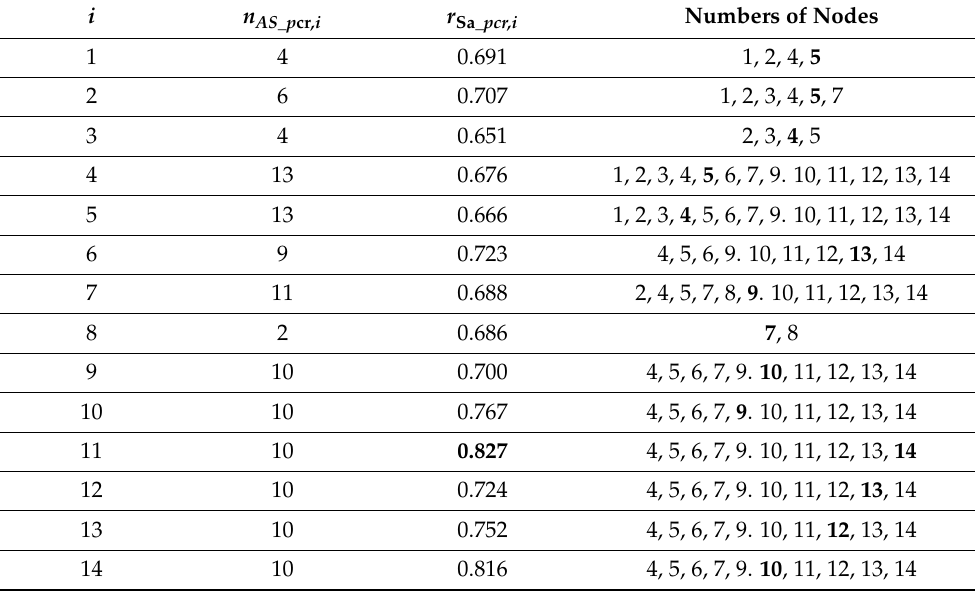
Table 3. Areas A S_ pcr , i i ∈ {1, 2, . . . , 14} associated with particular nodes of the test system.